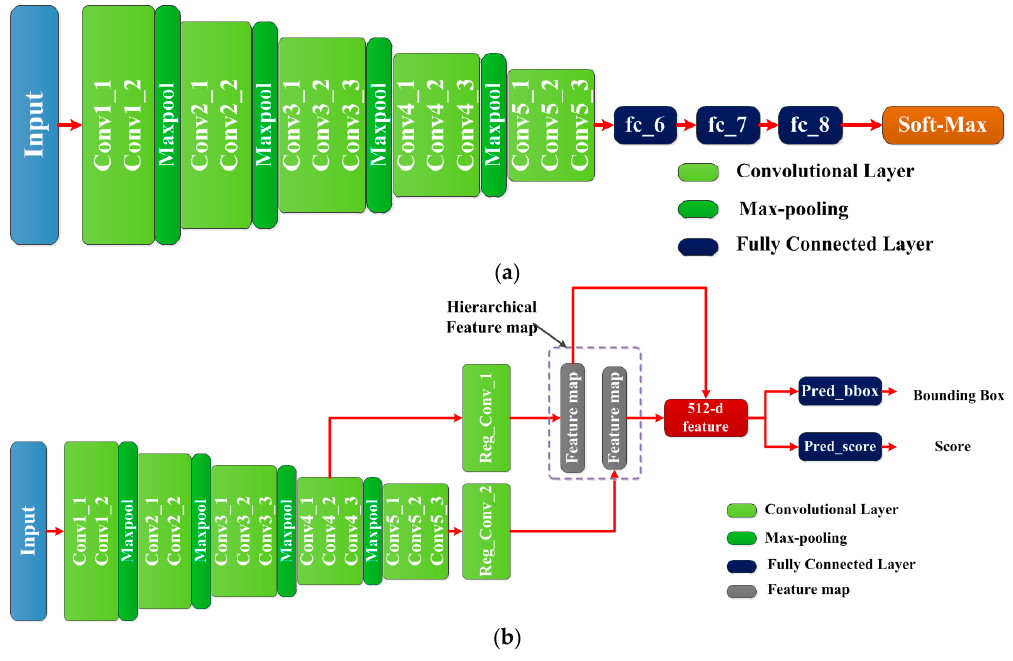
Figure 4. ( a ) The architecture of VGG-16 model; ( b ) The architecture of VPN.